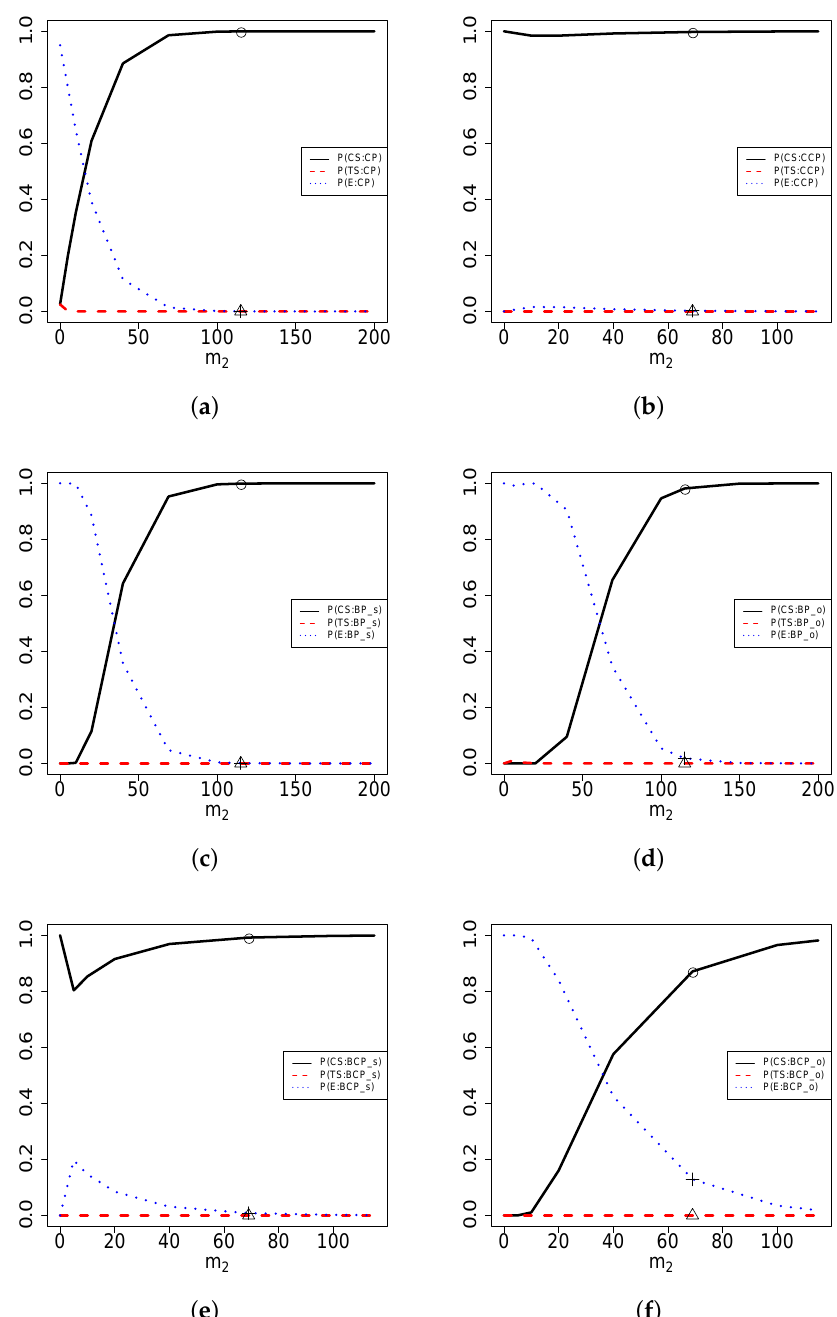
Figure 3. The probabilities of CS, TS, and E for CP, CCP, BP, and BCP as functions of m 2 when δ = 1, which favors control. ( a ) CP; ( b ) CCP; ( c ) BPs; ( d ) BPo; ( e ) BCPs; ( f ) BCPo. (3) The central left plot is for BP with a sceptical prior ( d 0 = µ s = 0). We have P ( CS:BP_s ) = 0, lim P ( TS:BP_s ) = 0, lim P ( E:BP_s ) = lim m 2 → 0 + m 2 → 0 + m 2 → 0 +